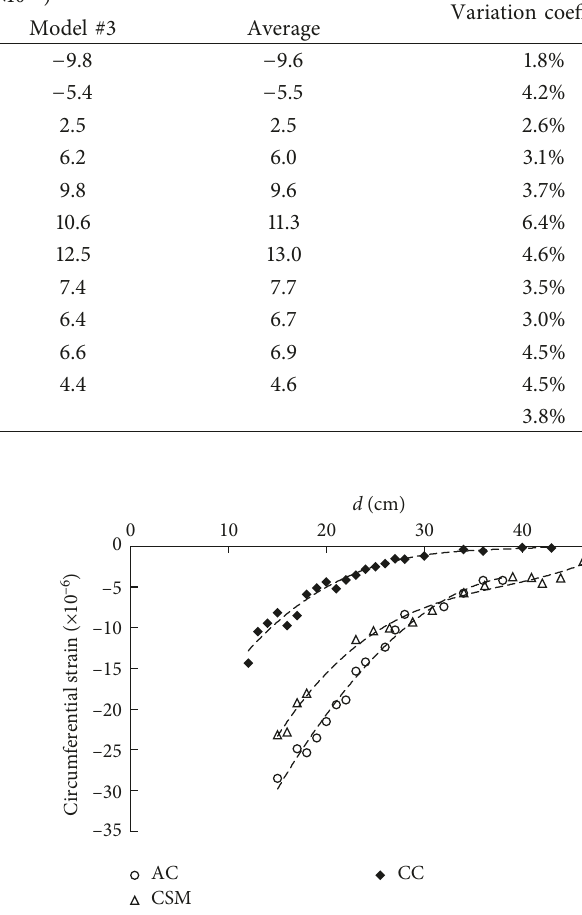
Figure 14: Circumferential strain test results of models with dif- ferent pavement materials.